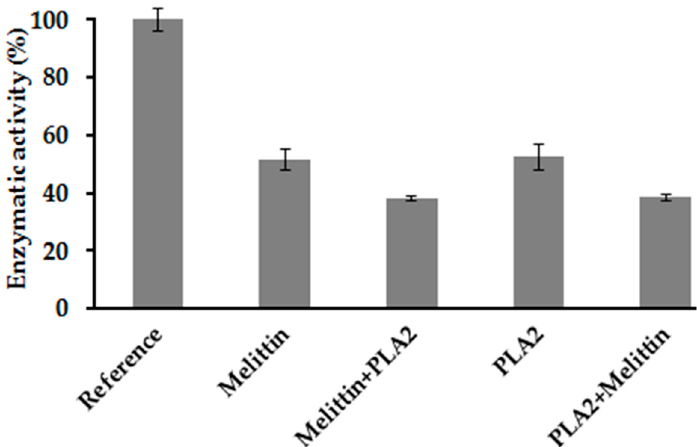
Figure 6. Synergistic action of melittin and PLA 2 on the membrane E. coli F 1 F 0 -ATPase. Reference shows maximal enzymatic activity (100%) obtained for an enzymatic reaction in optimal conditions and in the absence of inhibitor. (ATP) = 100 µ M, (Melittin) = 9 µ M, and (PLA 2 ) = 2.5 µ g / mL. Error bars show the standard deviation obtained from experiments done in triplicate.